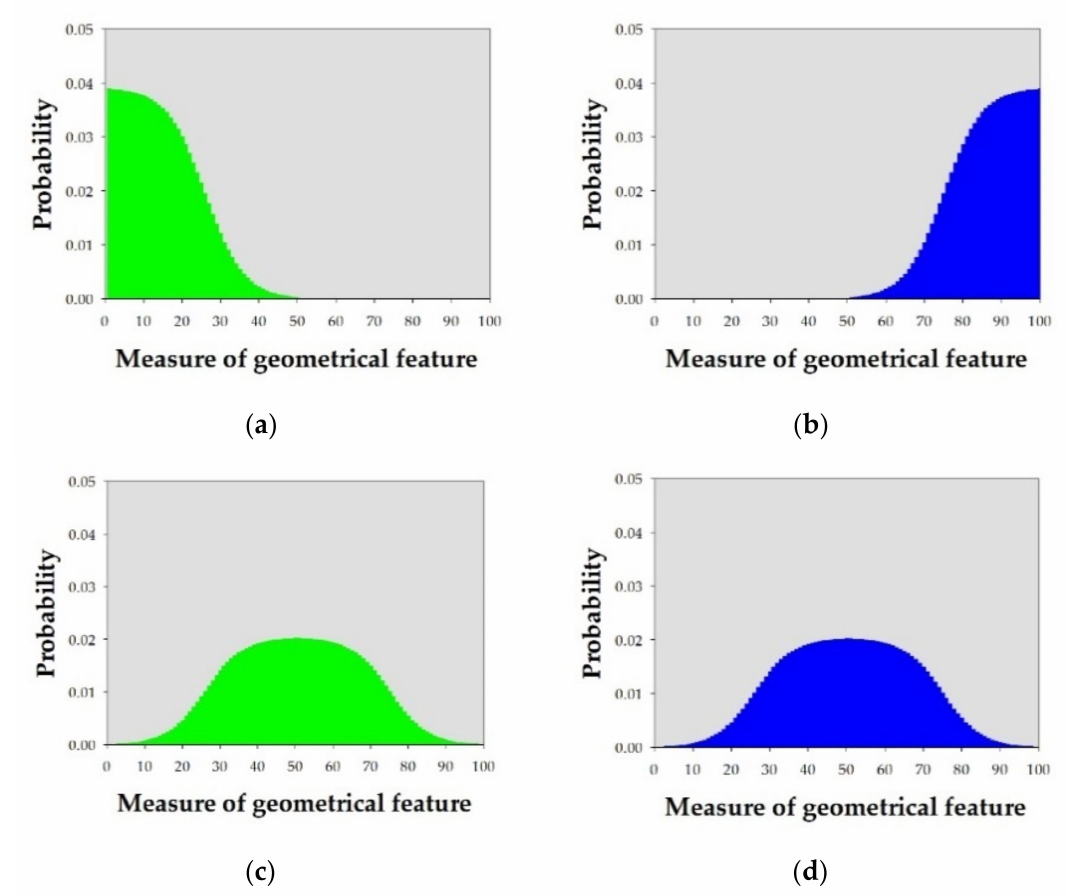
Figure 3. Two pairs of hypothetical PDFs: PDFs ( a , b ) represent very contrasting pairs of PDFs, while PDFs ( c , d ) represent exactly matching PDFs. We selected nine metrics out of the 45 metrics reviewed in [29], where the nine selected metrics resulted in a similarity of 0 for ( a , b ) and a similarity of 1 for ( c , d